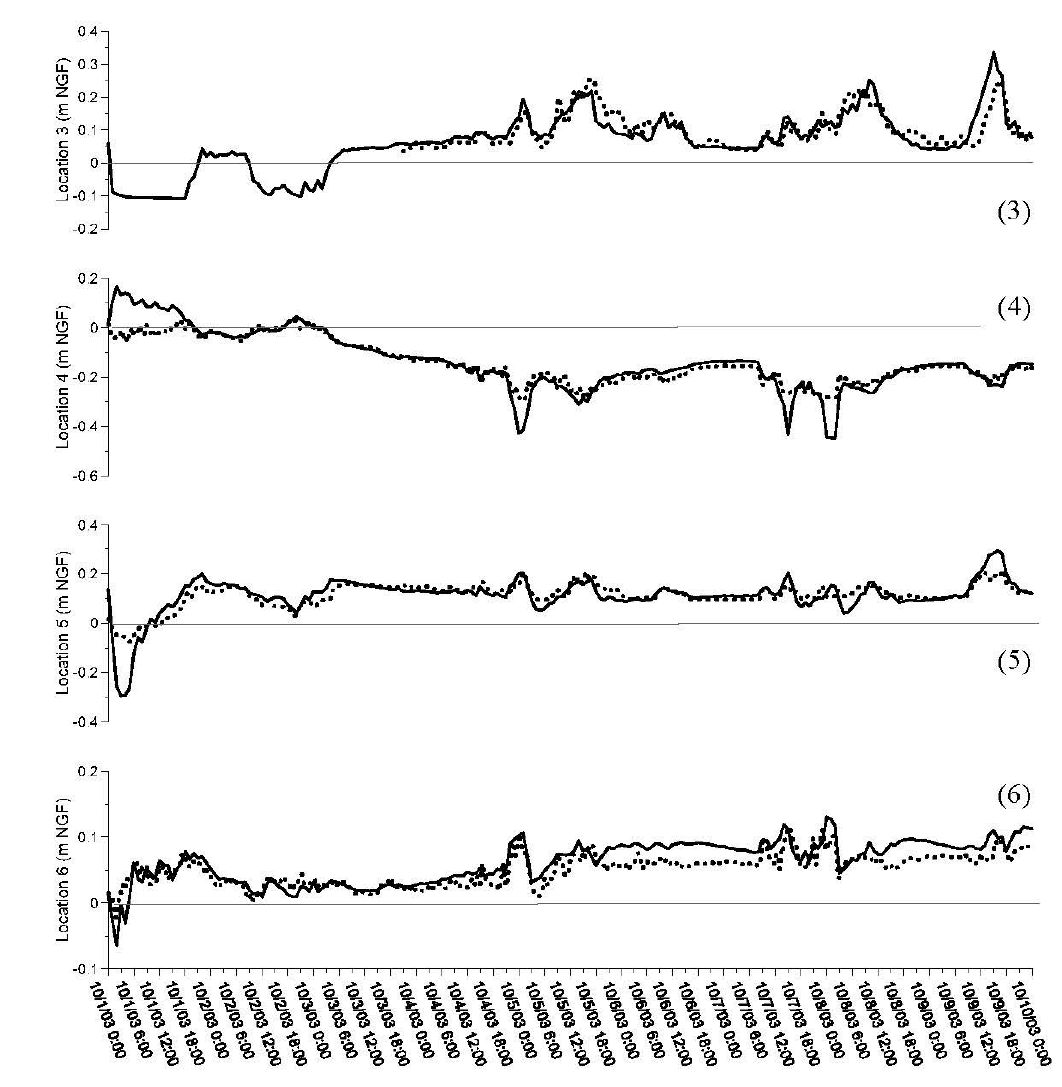
Figure 6. Measured wind vectors at the meteorological station B, measured and modeled water levels at locations one to six (see Figure 1) from 1 October to 10 October 2003. Modeled water levels are shown with solid lines and measured water levels with dotted lines. Measured wind vectors at the meteorological station A are not represented for the sake of legibility of the